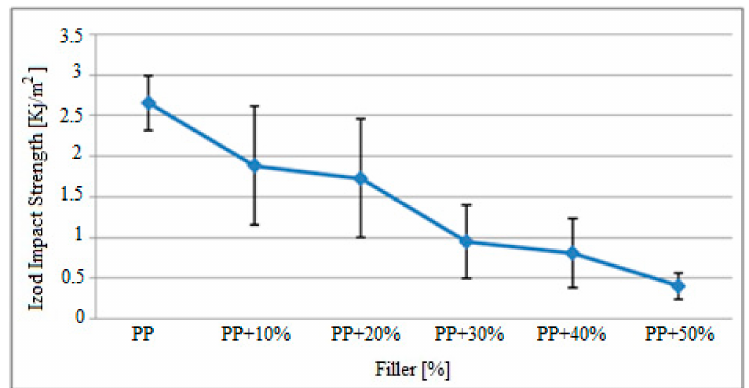
Figure 10. Variation in Izod impact strength of the filler-reinforced polypropylene matrix specimens after gamma radiation.